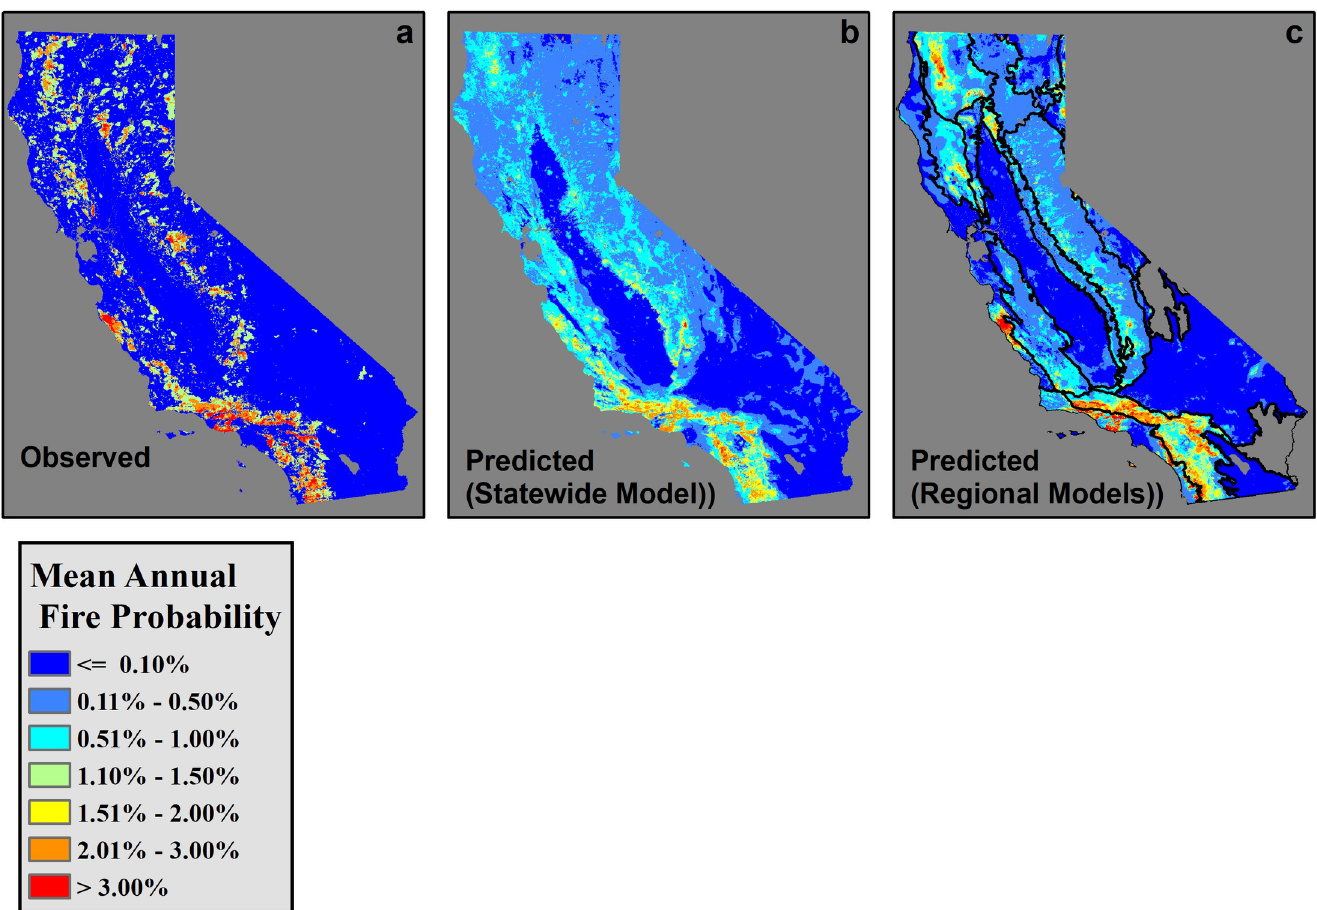
Fig 2. (a) Observed mean annual fire return probabilities, (b) predicted mean annual fire probabilities from 1970–2016 produced by the statewide model, and (c) by a composite of all regional models. Boundaries between regions are delineated by black lines in predictions developed by regional